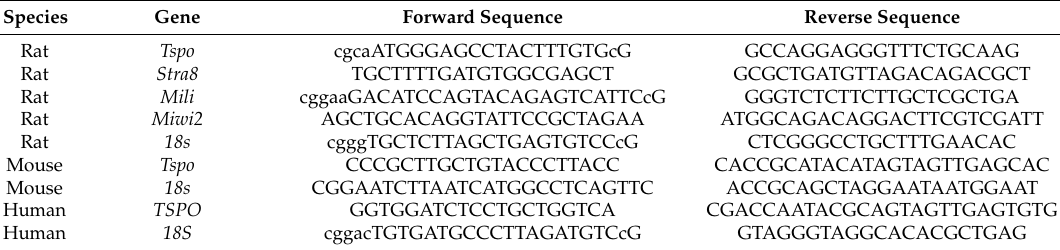
Table 3. Quantitative real time PCR primers. Lower case character letters in sequences were added by the primer designing program and are not part of the gene